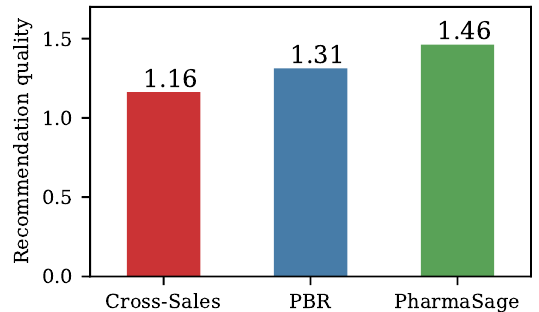
Figure 4. Average recommendation quality among the top 15 recommended articles for 25 evaluated products. Recommendations are computed based on the graph incorporating raw cross-selling statistics and the graph, where the edge weights have been recomputed using the probability approach (PBR). PharmaSage is optimized based on the PBR approach as the input.